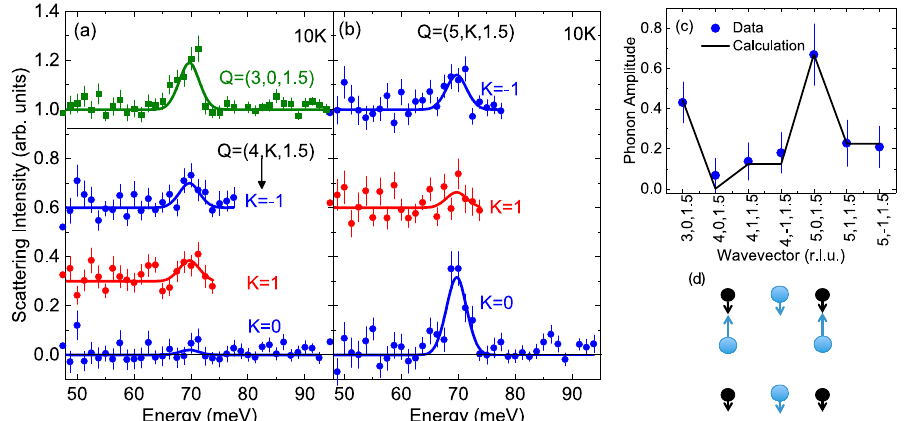
Figure 3. Zone-center bond-stretching phonon. ( a , b ) Solid line is the result of a multizone fit (see text) to the background-subtracted data (symbols). ( c ) Integrated intensity of the phonon at different wavevectors compared with the prediction based on the eigenvector shown in ( d ). ( d ) Eigenvector of the bond-stretching phonon. Small black circles represent Cu ions, large blue circles represent O. Arrows represent the phonon eigenvector drawn to scale. The eigenvector was extracted from phonon intensities in ( a , b ). (From Ref. [9]).